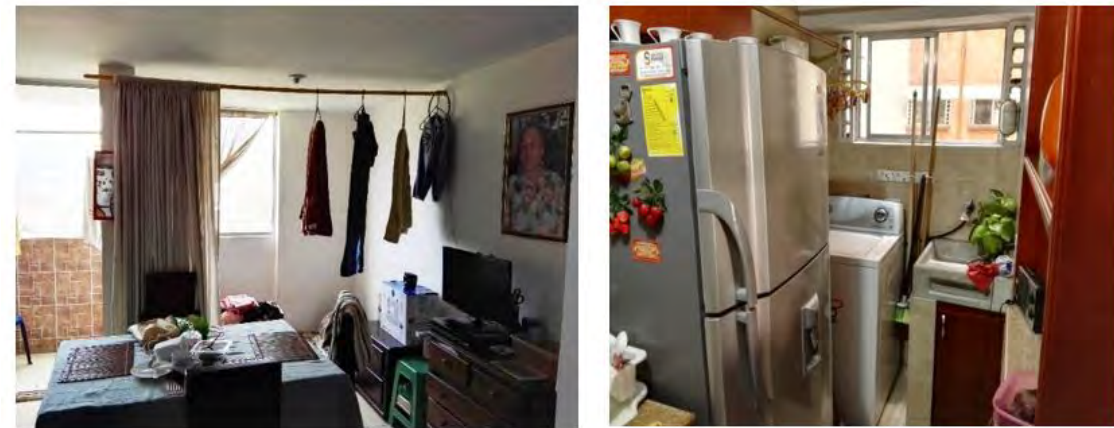
Figure 4. Need of adequate spaces to hang the laundry